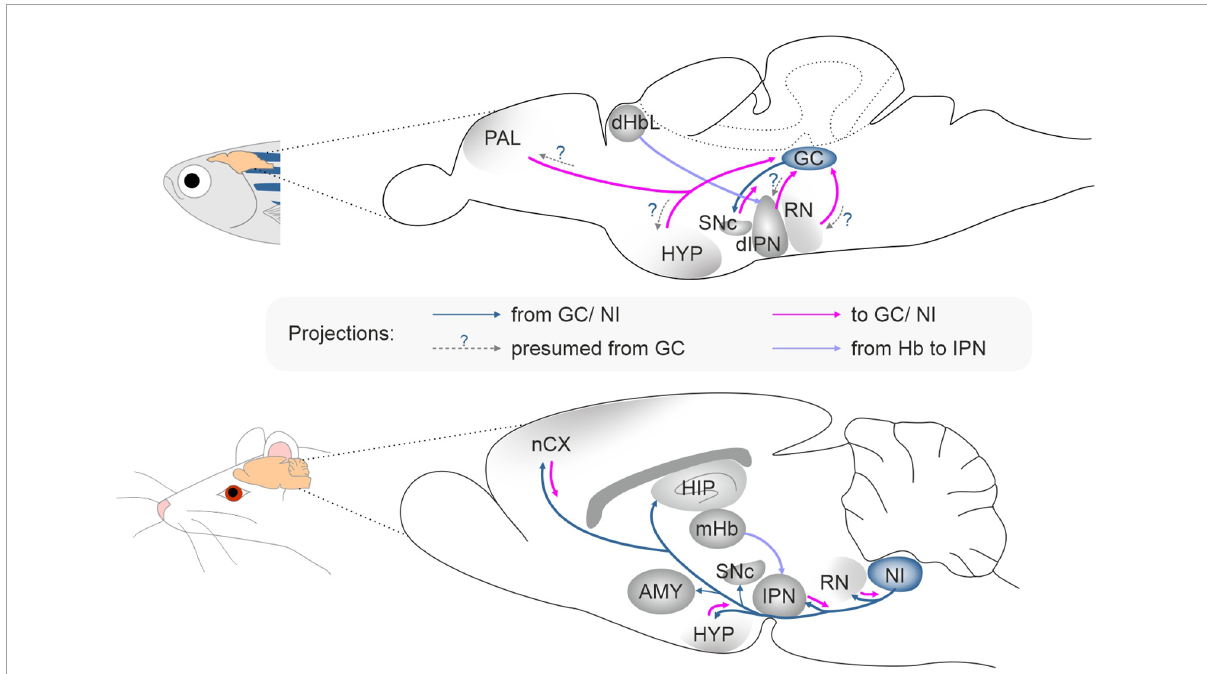
FIGURE2 The connectivity pattern of the griseum centrale in zebrafish and the nucleus incertus in rat. AMY, amygdala; dHbL, dorsal habenula lateral part; dIPN, dorsal interpeduncular nucleus; GC, griseum centrale ; HIP, hippocampus; HYP, hypothalamus; IPN, interpeduncular nucleus; nCX, neocortex; mHb, medial habenula; NI, nucleus incertus ; PAL, pallium; RN, raphe nucleus; SNc, substantia nigra pars